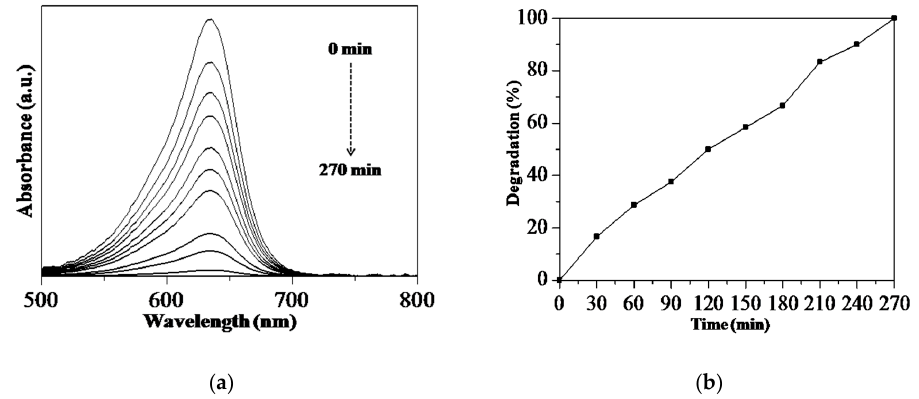
Figure 9. Degradation of methylene blue (MB) for 270 min under ( a ) UV-Vis and ( b ) plot of degradation (%) against time.